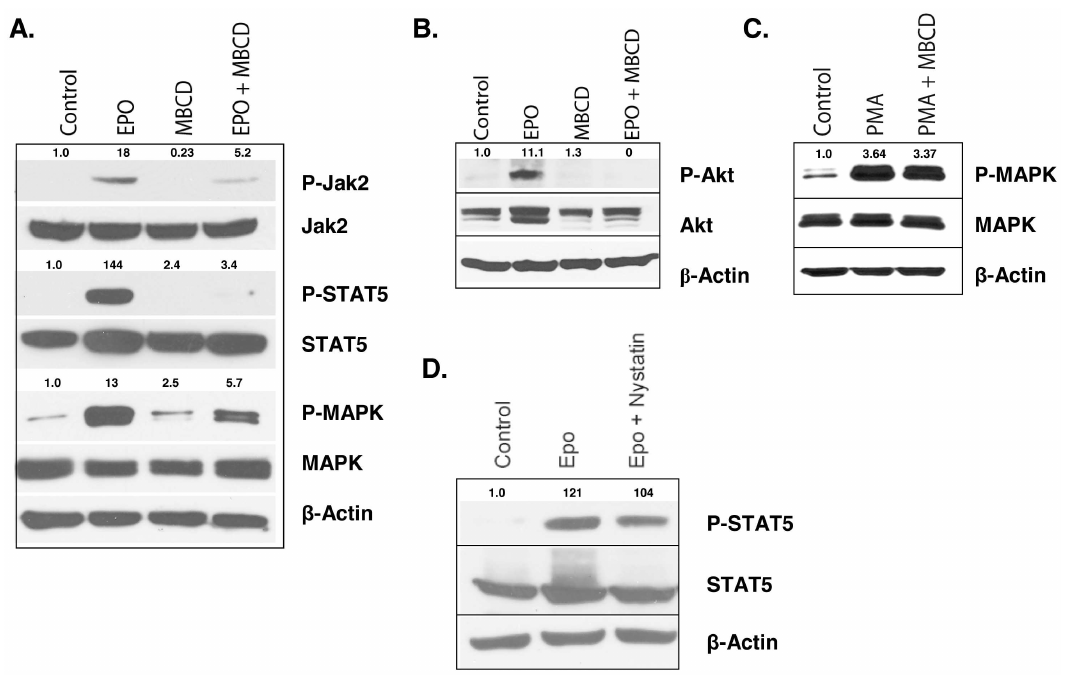
Figure 4. Raft integrity is necessary for Epo-induced signaling. (A) UT7 cells were starved for 2 h then pretreated with MBCD for 30 min and stimulated with 3 U/ml Epo for 10 min; lysates were immunoblotted with the indicated antibodies. (B) UT7/Epo cells were starved for 2 h then pretreated with MBCD for 30 min and stimulated with 3 U/ml Epo for 10 min. Lysates were immunoblotted with P-Akt. The findings show abrogation of Akt phosphorylation following MBCD pretreatment. (C) UT7 cells were pretreated with MBCD for 30 min, then stimulated with PMA for 30 min. (D) UT7 cells were starved for 2 h then pretreated with Nystatin for 30 min and stimulated with Epo for 10 min. Immunoblots for phospho-STAT5, STAT5, and b -actin antibodies with densitometry analysis. All westerns are representative of at least 2 independent